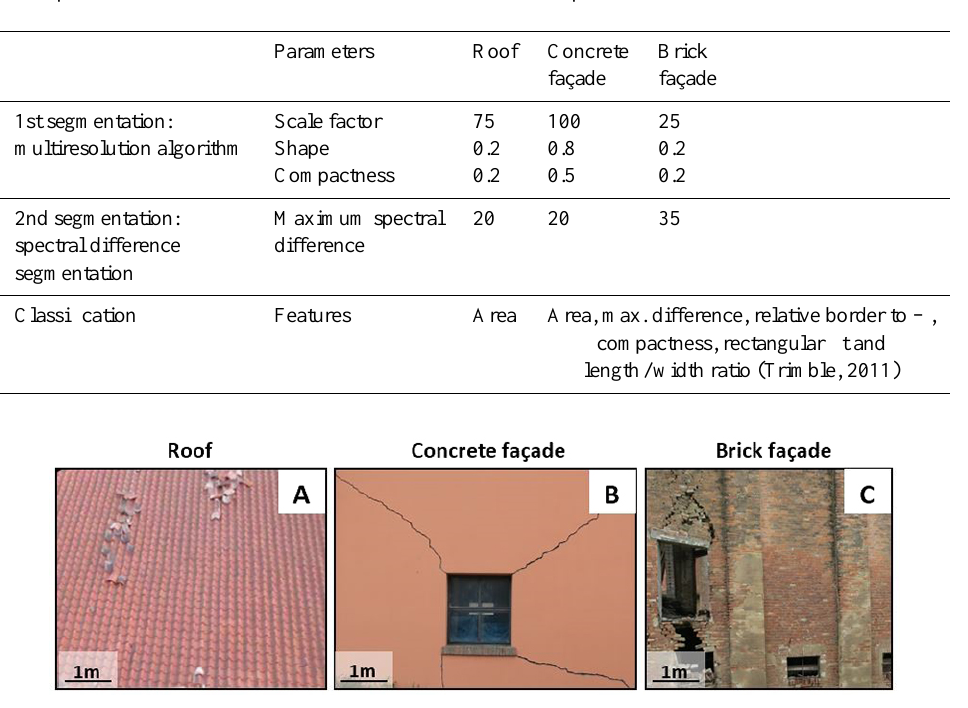
Table 1. Segmentation parameters and classification features for the three developed rule sets.